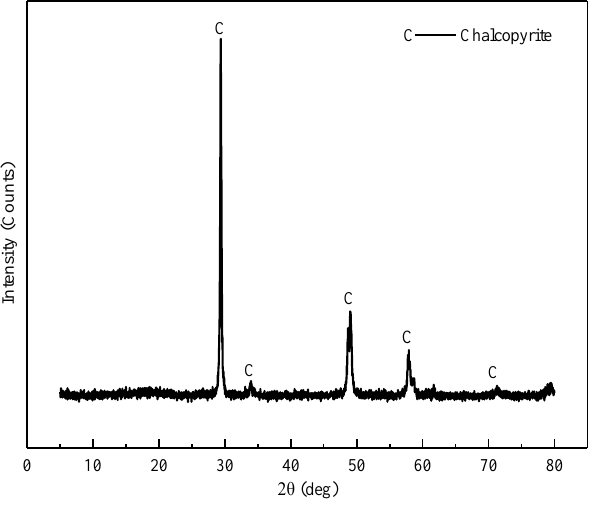
Figure 1. XRD pattern of chalcopyrite.